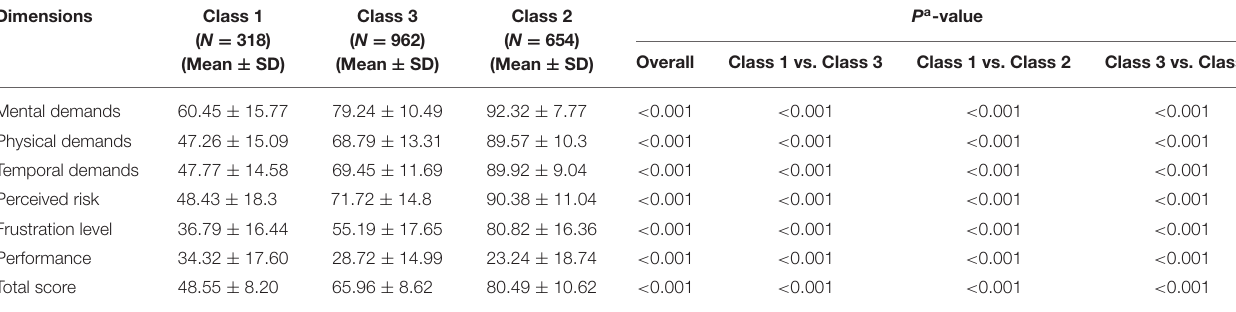
TABLE 4 | Comparisons of the different subtypes by mental